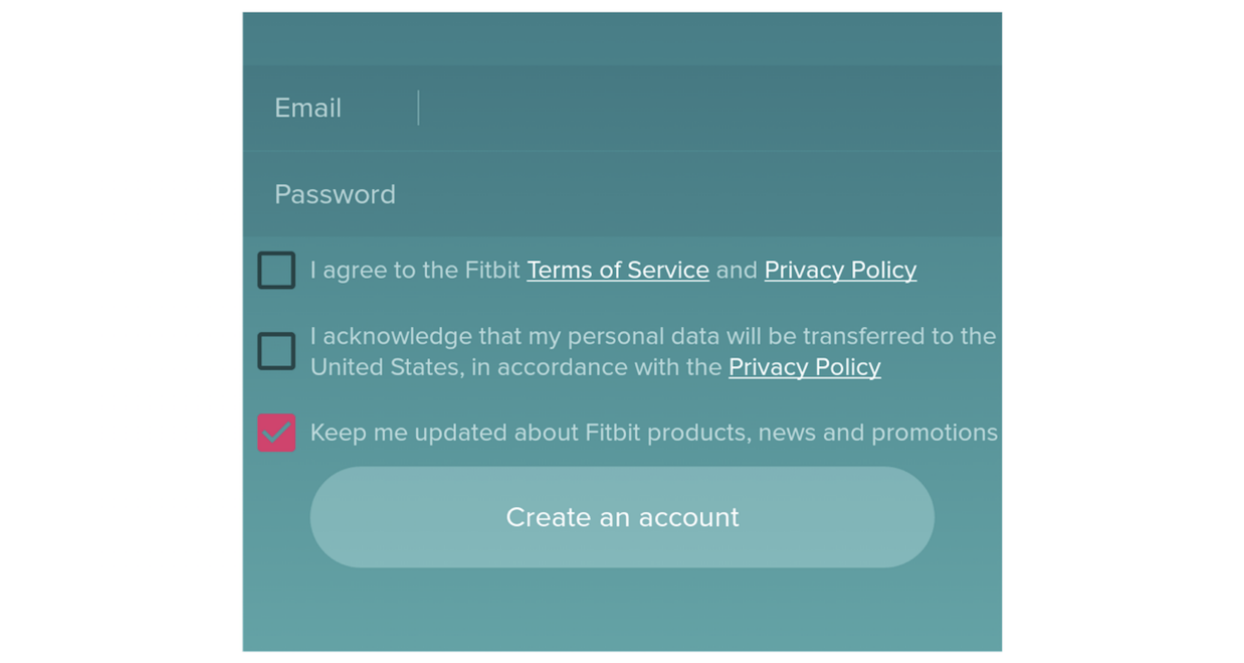
Figure 6. Partial screenshot of the Fitbit Android app account creation